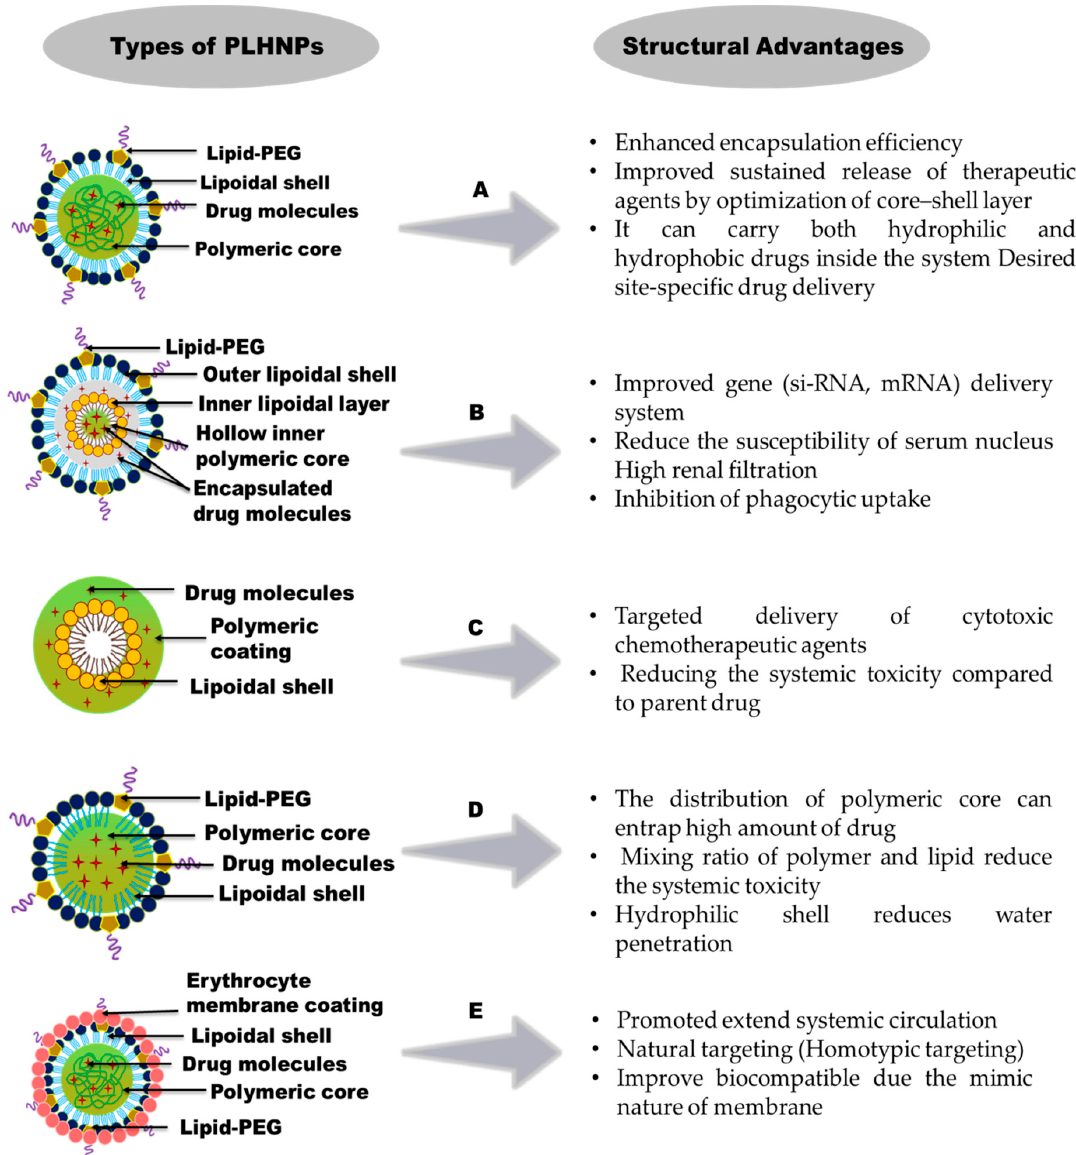
Figure 4. Differenttypesofpolymer-lipidhybridnanoparticlesandtheirstructuraladvantages. ( A )Polymer Figure 4. Different types of polymer ‐ lipid hybrid nanoparticles and their structural advantages. ( A ) corelipidshell. ( B )Coreshell-typehollowlipid-polymer-lipidhybridnanoparticles. ( C )MonolithicPLHNPs. Polymer core lipid shell. ( B ) Core shell ‐ type hollow lipid ‐ polymer ‐ lipid hybrid nanoparticles. ( C ) ( D ) Polymer-caged liposome. ( E ) Erythrocyte membrane coated Monolithic PLHNPs. ( D ) Polymer ‐ caged liposome. ( E ) Erythrocyte membrane coated PLHNPs.